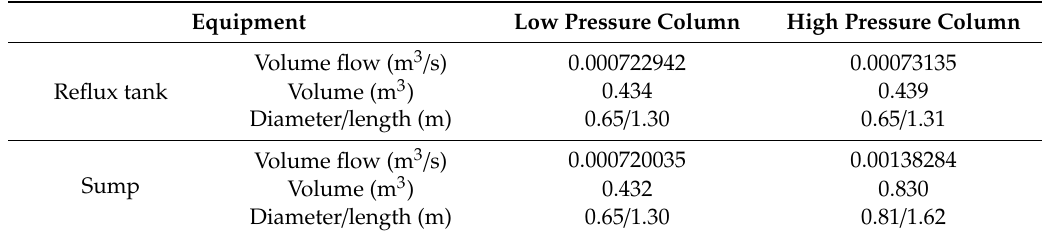
Table 5. The size of devices for the partial HIPSD process.